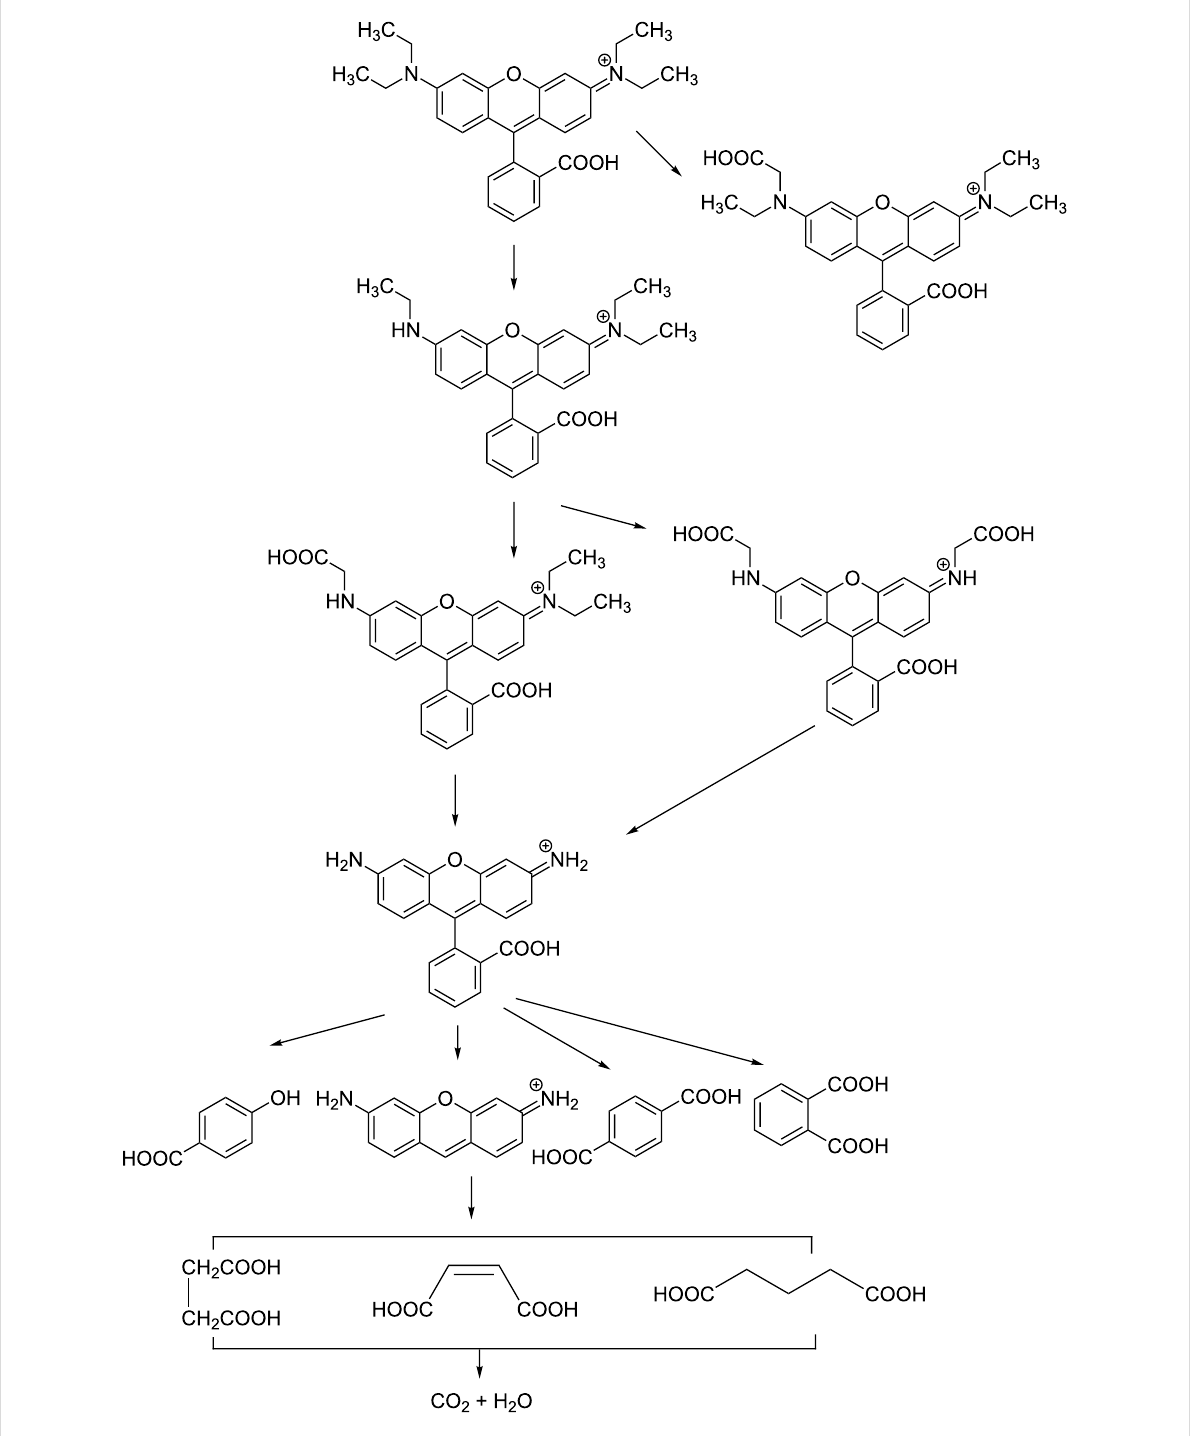
Figure 8: Possible intermediates of rhodamine B during photocatalytic degradation process.